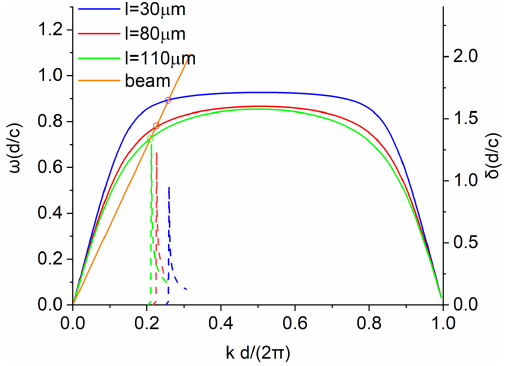
Figure 4: Comparison of the dispersion relations (solid lines) and the growth rates (dash lines) for different thicknesses of the dielectric ε r = 2 . 7.